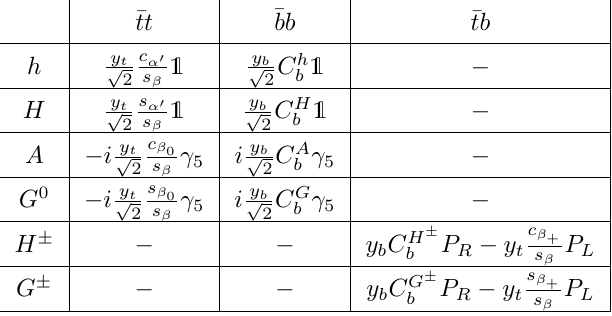
Table 4 . Yukawa couplings.